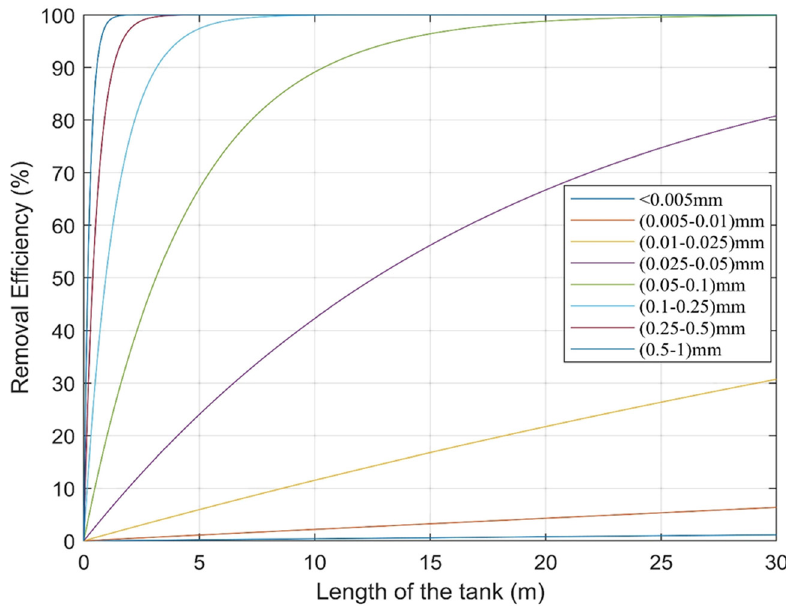
Figure 5: Removal e ffi ciency for each particle size without fl occulation process for coded